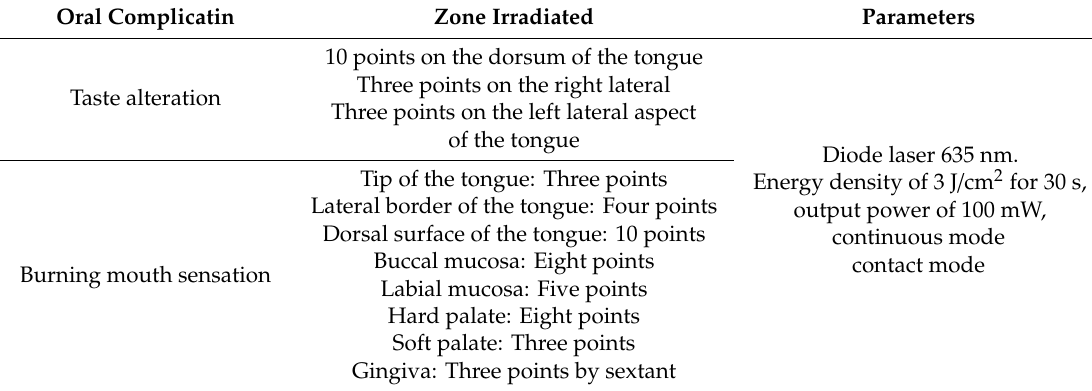
Table 9. Photobiomodulation therapy for the management of taste alteration. Oral Complicatin Zone Irradiated Parameters 10 points on the dorsum of the tongue Three points on the right lateral Taste alteration Three points on the left lateral aspect of the tongue Diode laser 635 nm. Tip of the tongue: Three points Energy density of 3 J / cm 2 for 30 s, Lateral border of the tongue: Four points output power of 100 mW, Dorsal surface of the tongue: 10 points continuous mode Buccal mucosa: Eight points contact mode Burning mouth sensation Labial mucosa: Five points Hard palate: Eight points Soft palate: Three points Gingiva: Three points by